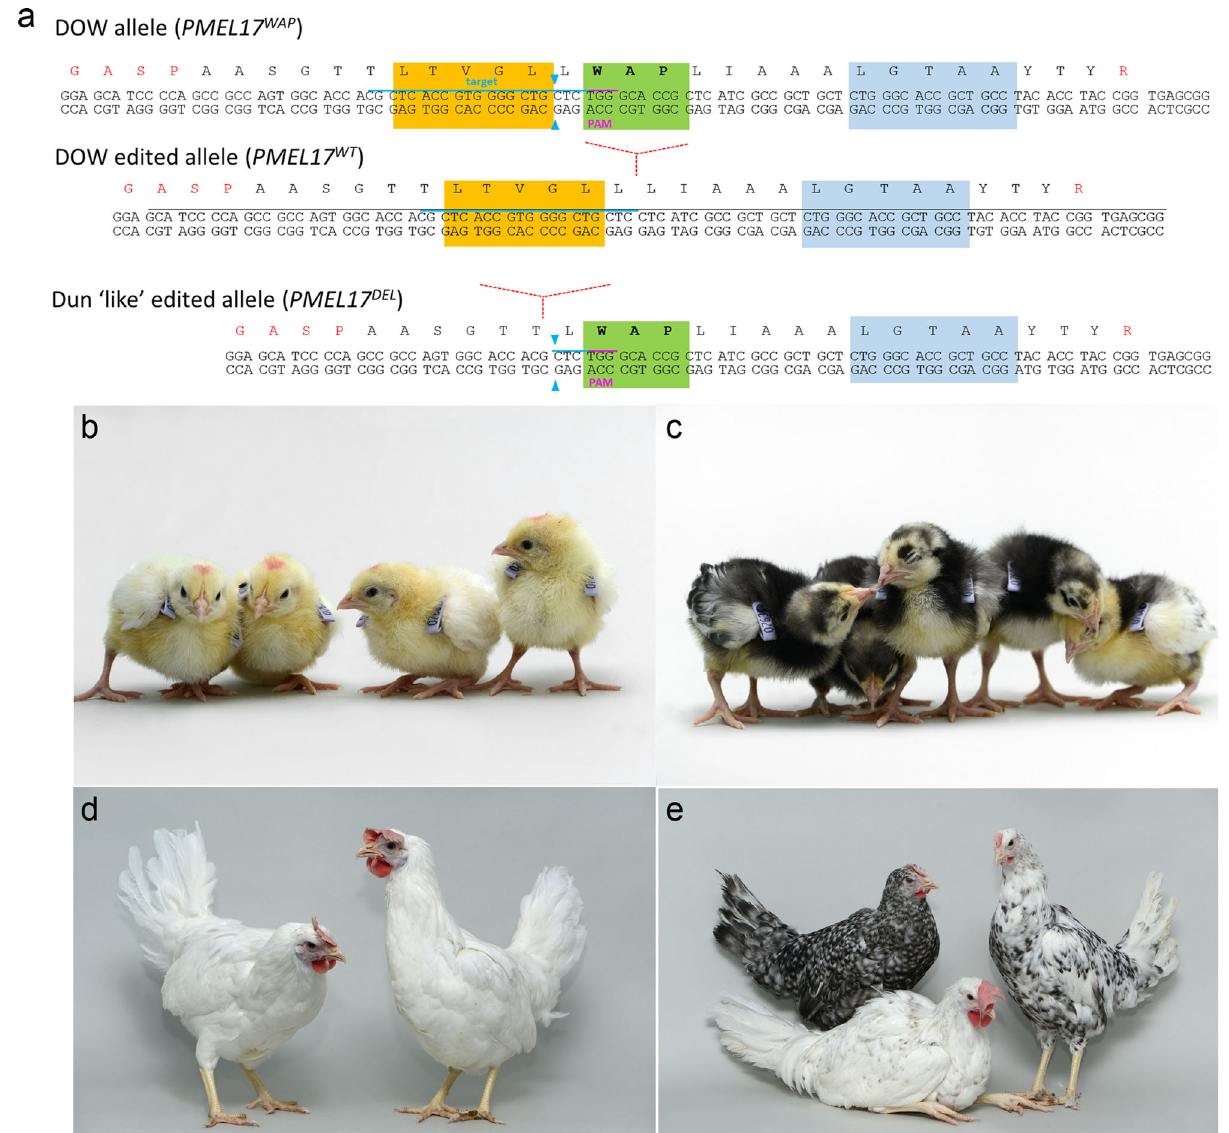
Fig. 2 Genome edit to remove the DOW allele from a White leghorn chicken breed. a PMEL17 locus containing the DOW allele (WAP insertion) within the 10th exon which encodes for the PMEL17 transmembrane domain (amino acids in black). Genome-edited PMEL17 locus removing the WAP (highlighted green). Genome-edited second allele creating a fi ve amino acid Dun-like deletion (deleted amino acids highlighted yellow). The fi ve amino acids deleted in the Dun allele are highlighted in blue. b , d Wild-type WL Line 6 chicks and adults. c , e PMEL17 edited chicks and adults; females (standing) were barred and speckled feathers, males (sitting) were white with black dots. All photographs of live birds at The Roslin